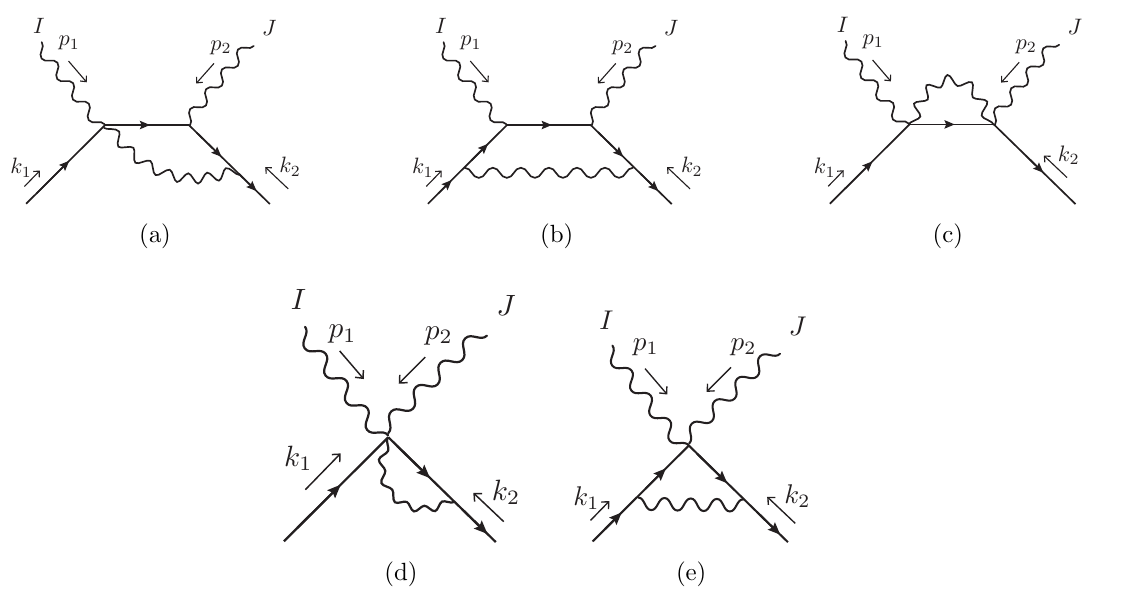
Figure 4. Corrections to the four-point function of two scalars and two gauge